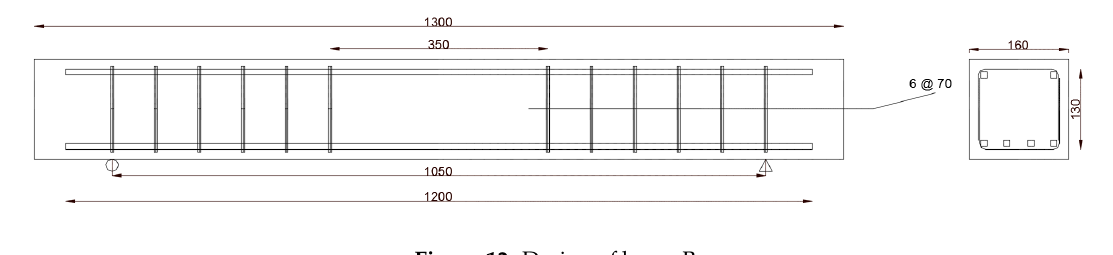
Figure 11 . Design of beam A.